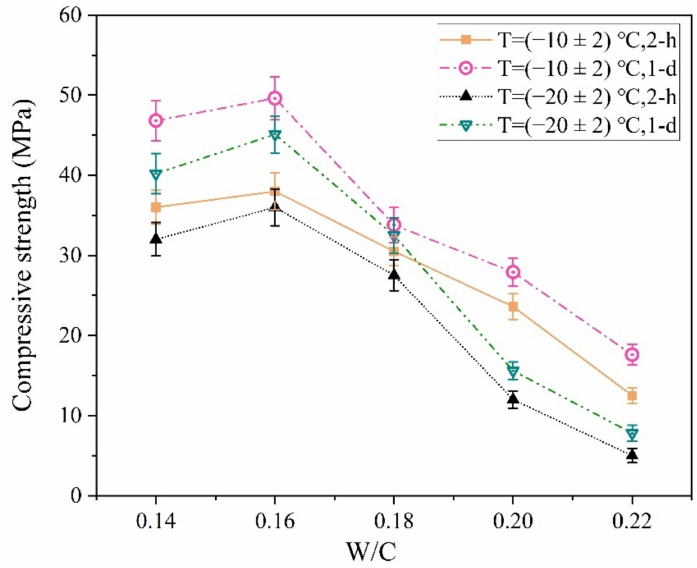
Figure 13. The influence of the W / C ratio on the early strength of the magnesium phosphate cement concrete